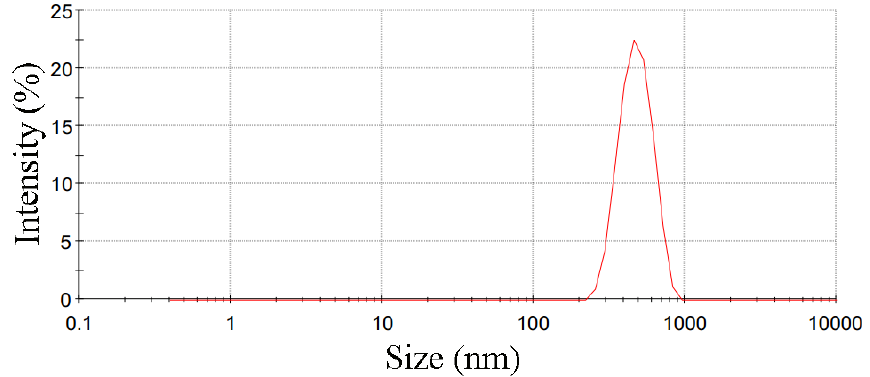
Figure 1. The size and size distribution of calcined powder.